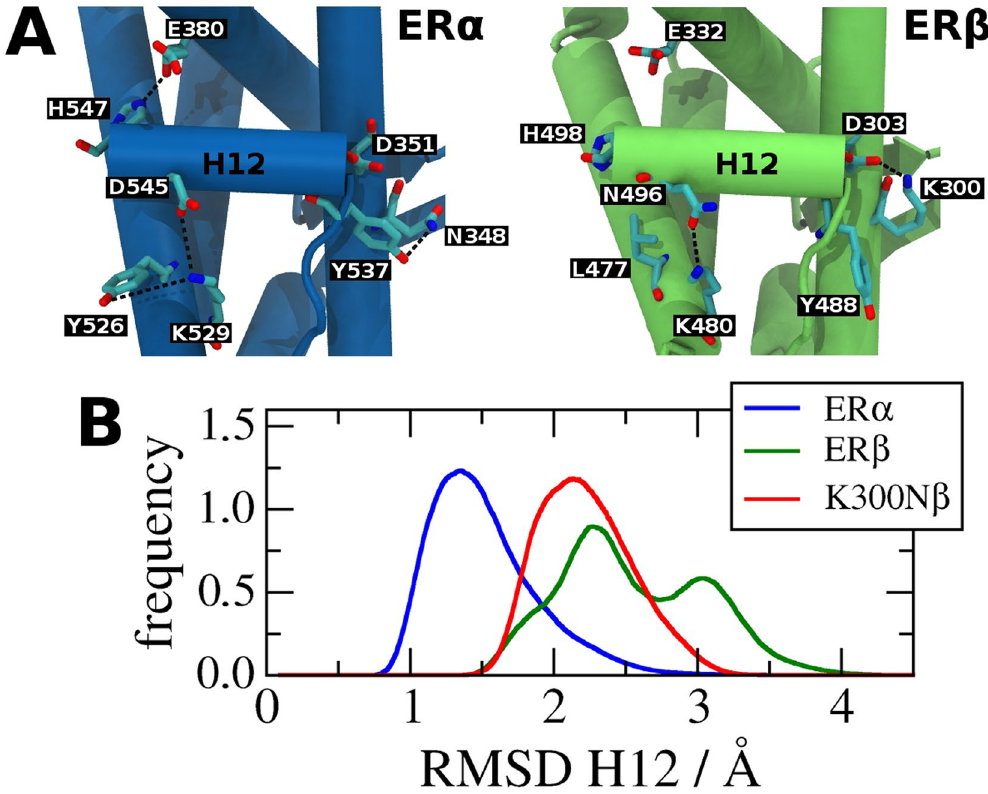
Figure 4. Stability of H12 canonical position in ER subtypes: ( A ) Comparison of main interactions between H12 and the remaining canonical LBD structures of the ER α LBD-E2 (blue, PDB code 1QKU) and ER β LBD- E2 (green, PDB code 3OLS). ER α LBD-E2 has three hydrophilic interactions stabilizing H12 in its canonical position while ER β LBD-E2 has only one interaction. The position of histidine H498 was not obtained in 3OLS structure. Its position was added based on the structure of the phosphorylated ER β LBD-E2 (PDB code 3OLL). ( B ) RMSD distribution of H12 computed with respect to MD simulation average structures of wild-type ER α LBD-E2 (blue), wild-type ER β LBD-E2 (green) and K300N mutant of ER β LBD-E2 (K300N β ). H12 of wild-type ER α shows a lower mobility than wild-type ER β . K300N β corresponds to the transformation β → α of one of the residues that stabilizes H12. As expected, this mutation reduces the mobility of this